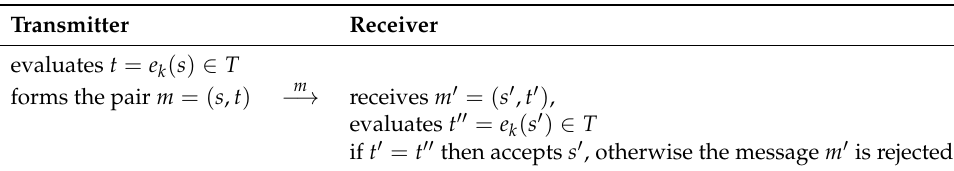
Table 1. Protocol of the transmission of a source s ∈ S